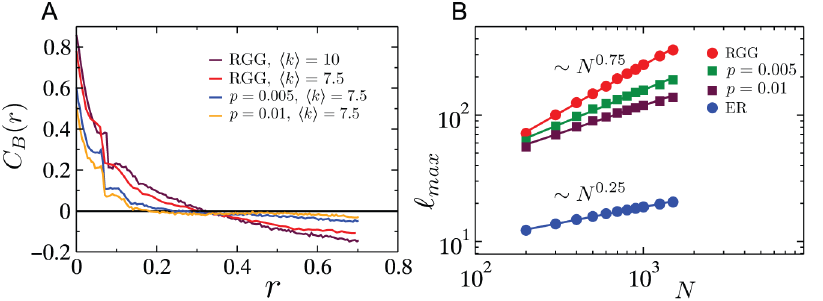
Figure 2. Correlations of vertex loads as a function of distance between vertices and extreme value characteristics of loads. (A) Load and distance correlations in RGGs and rewired RGGs with rewiring probability p (see text). Pearson correlation coefficient as function of distance r measured between two arbitrary nodes. Data were averaged over 100 network realizations for networks having 500 nodes. (B) System size dependence of the maximum vertex load in networks with S k T ~ 6 . Data were averaged over 2000 network realizations. The parameter p corresponds to the rewiring probability for links in the RGG.